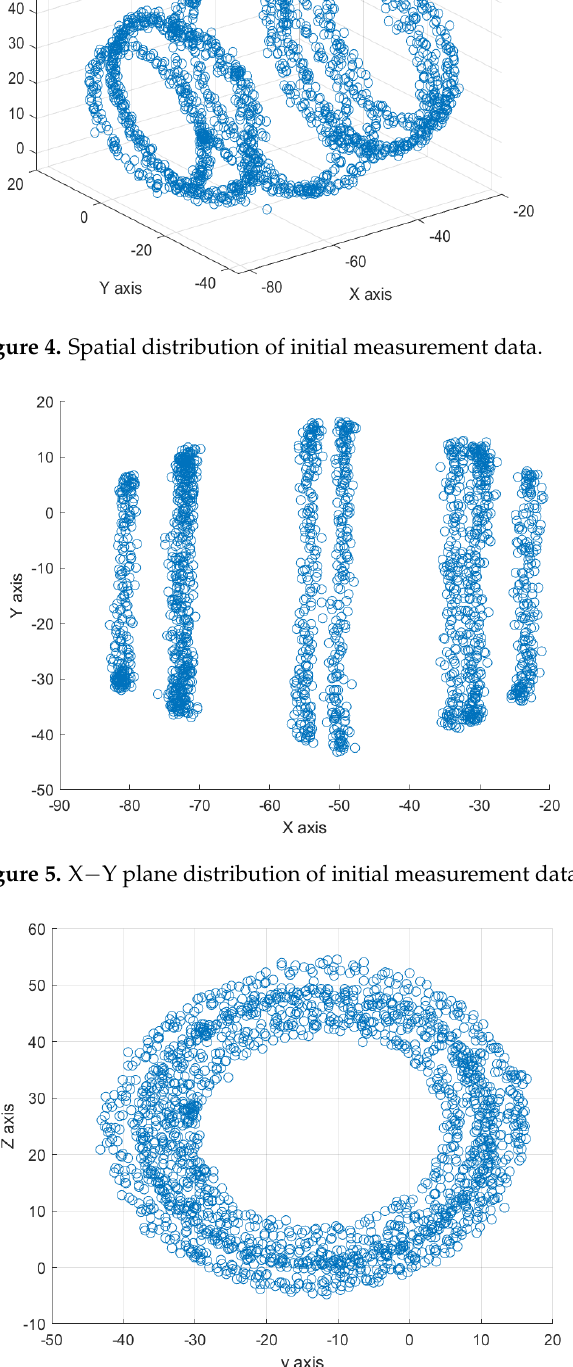
Figure 6. Y − Z plane distribution of initial measurement data.